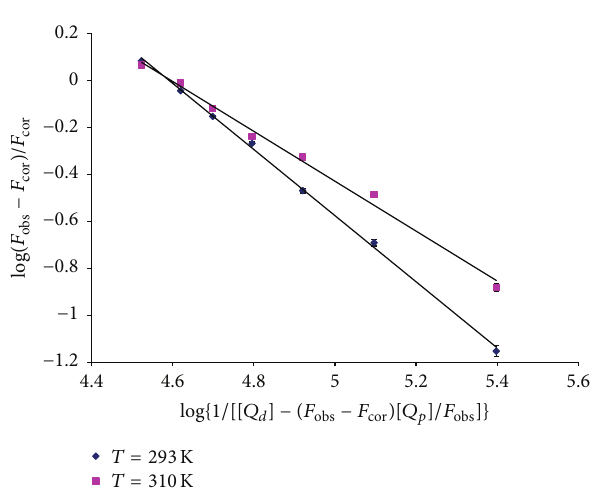
Figure 4: Double-log plots of liquiritigenin quenching effect on HAase fluorescence at different temperatures ( 𝑛 = 3